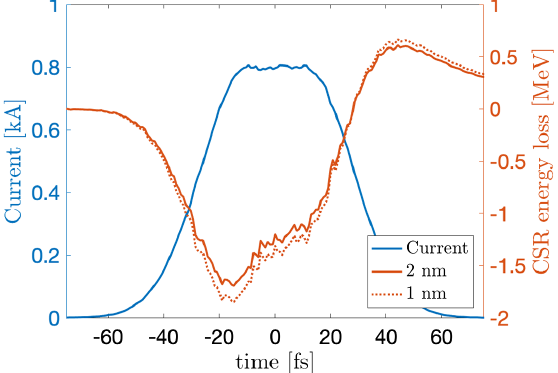
FIG. 12. Steady state CSR energy loss in the ideal beam in the last two chicane dipoles, where the beam is highly sensitive to energy distortions. The wake profiles are similar between the 1 and 2 nm EEHG tunes despite the difference in dispersion because of the weak dependence of the CSR on the different magnetic fields.